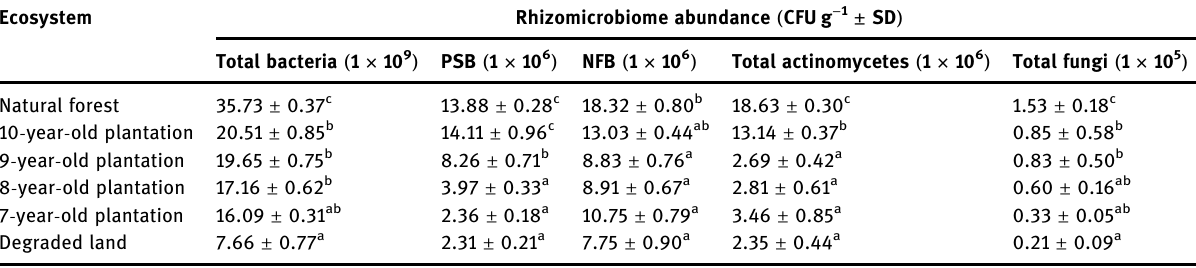
Table 6: Rhizomicrobiome in natural forest, oil palm, and degraded land ecosystems